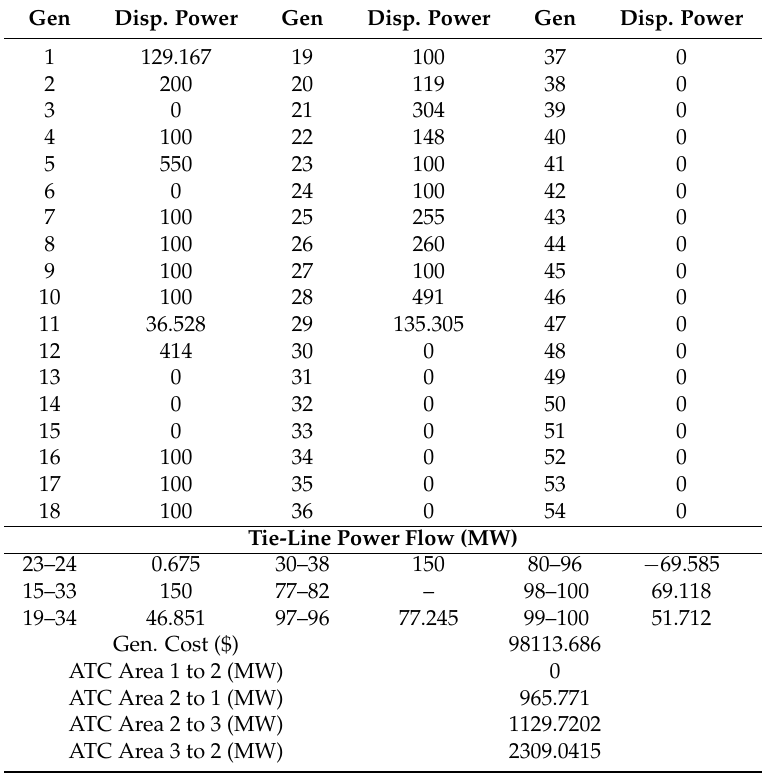
Table 9. ATC and Gen. Dispatch Results in IEEE 118-bus system with line 77–82